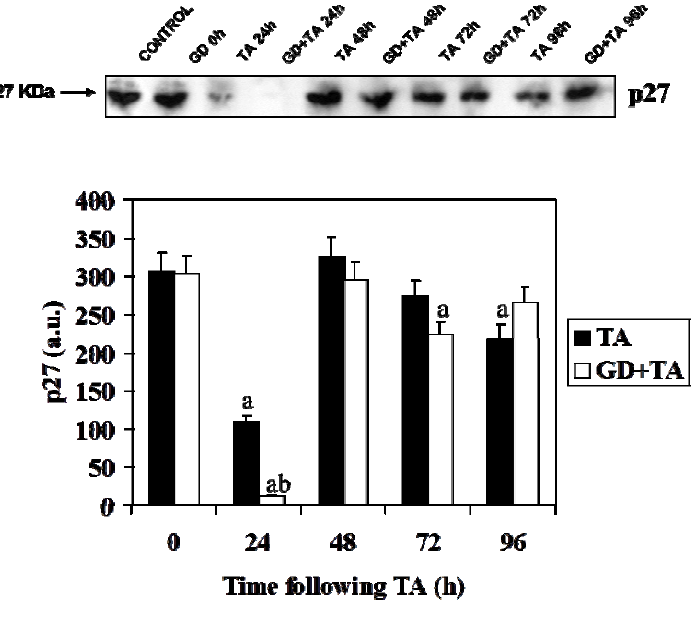
Figure 5. Effect of GD pre-treatment on levels p27 protein assayed by Western blot in liver homogenates of rats intoxicated with one sublethal dose of thioacetamide. Samples were obtained at 0, 24, 48, 72 and 96 h following thioacetamide (TA). The results, expressed in arbitrary units, are the mean ± SD of four determinations in duplicate from four rats. Differences against the respective control are expressed as (a) and differences due to GD are expressed as (b) p <